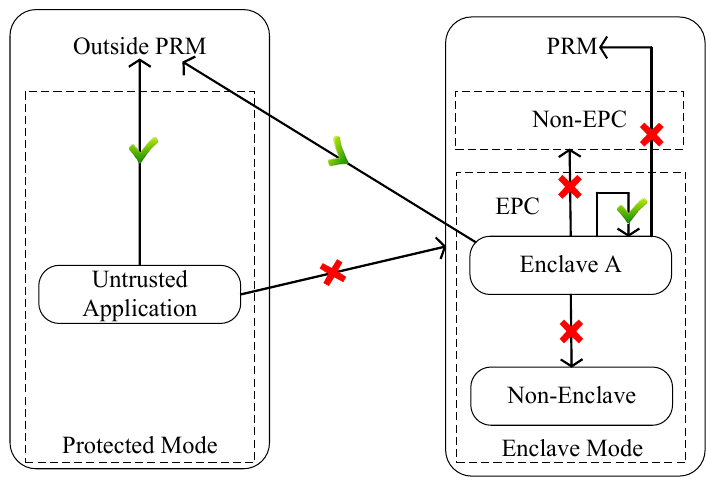
Figure 1. The access control of SGX.